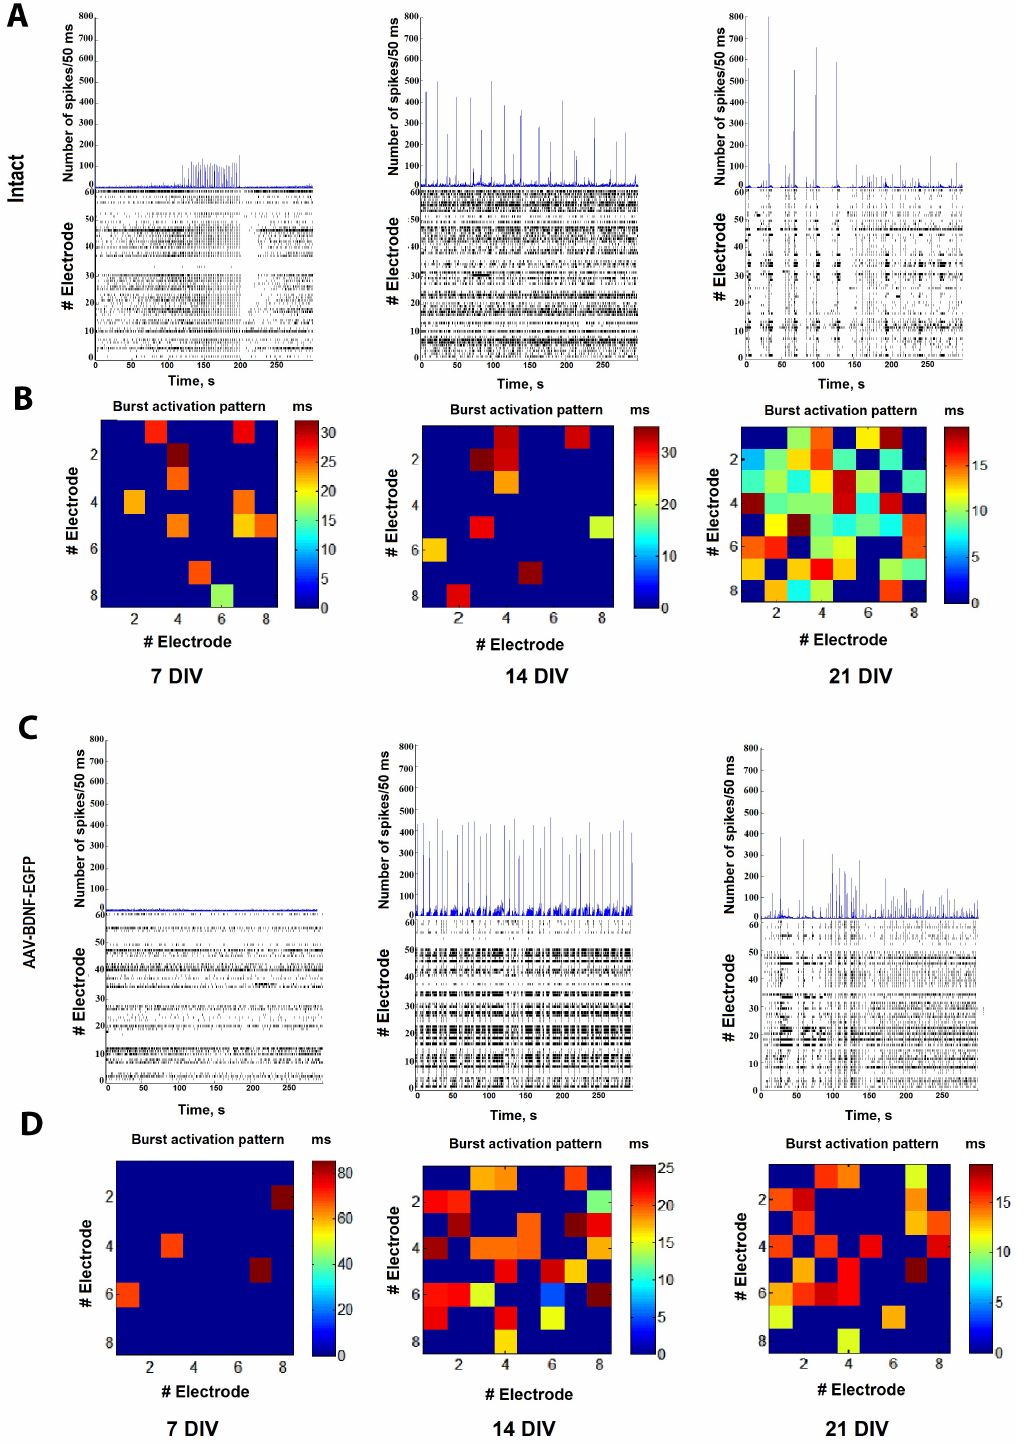
Figure 2. Spontaneous bioelectrical activity alterations in primary hippocampal cell cultures on 7, 14 and 21 days in vitro (DIV). ( A , C ) Number of spikes/50 ms and raster diagrams of spontaneous bioelectrical activity in primary hippocampal cultures: ( A ) sham, ( C ) AAV-Syn-BDNF-EGFP; ( B , D ) representative examples of the activation pattern of spontaneous bioelectrical activity in primary hippocampal cultures: ( B ) sham, ( D ) AAV-Syn-BDNF-EGFP. The colour scale corresponds to the time of occurrence of the first spike in the network burst and is presented in squares according to the electrodes of the multi-electrode array. The data show the absence of changes in the main parameters of spontaneous bioelectrical activity in primary culture with BDNF overexpression compared with sham cultures. Changes in the activation pattern were detected on 21 DIV.